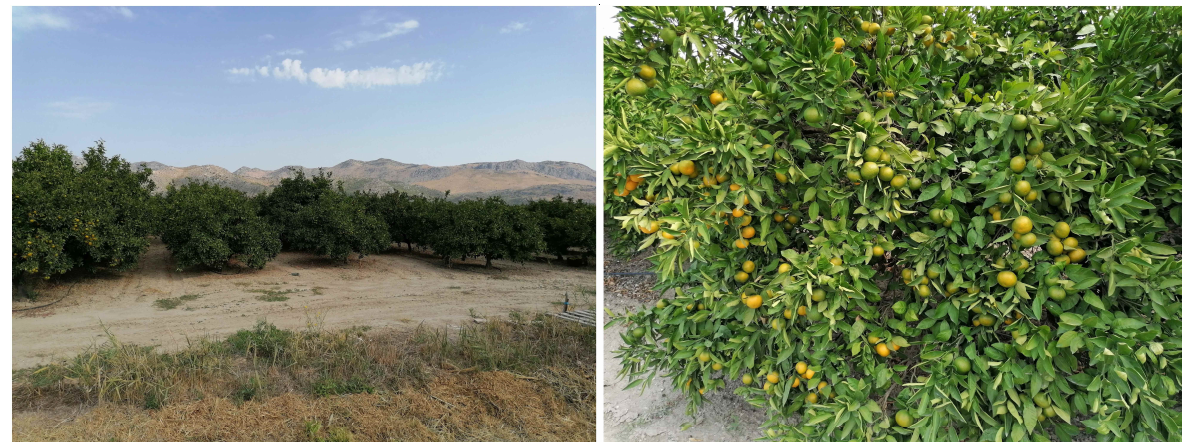
Figure 2. A terrestrial representation of tangerine trees during the fieldwork in the study area.